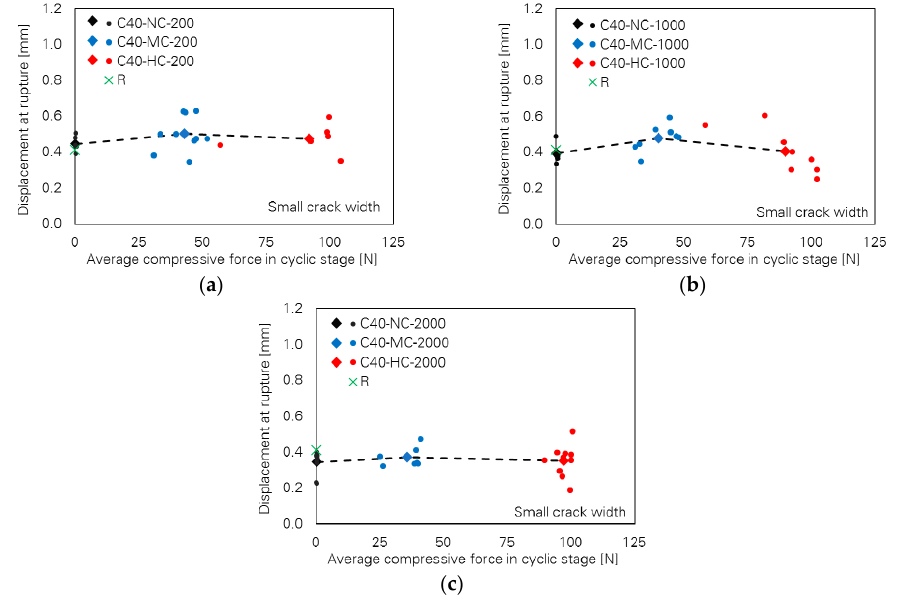
Figure 1. Influence of cyclic compressive force level on fibre displacement at rupture of the specimens with small crack width; number of cycles: ( a ) 200, ( b ) 1000 and ( c ) 2000.